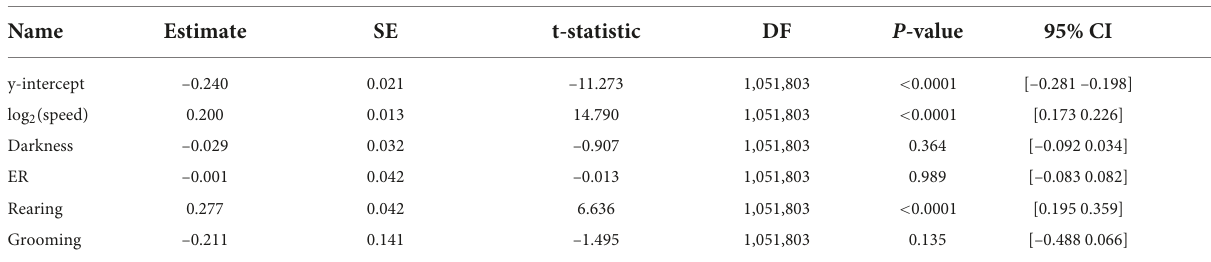
TABLE 6 Results of a linear mixed-effects model of the z-scored (cid:49) F/F of cholinergic activity with six fixed effects, which include y-intercept, the logarithm of allocentric neck movement speed, darkness, and the behavioral communities as identified through